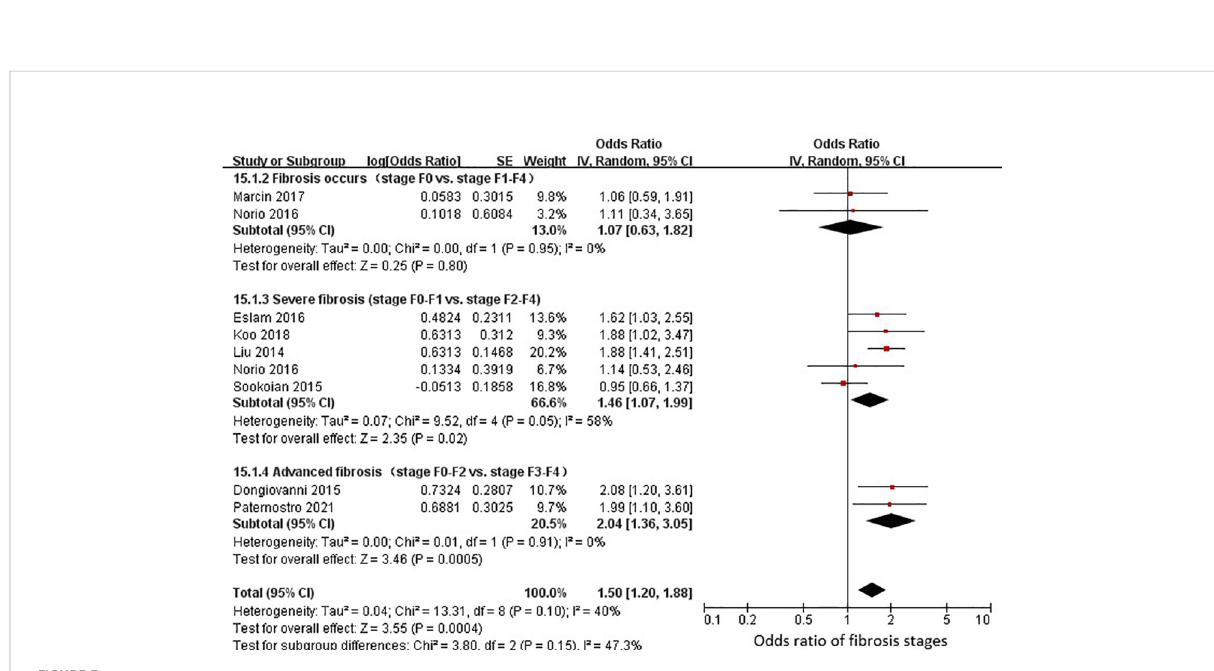
FIGURE 3 rs58542926 T allele was associated with a higher odds ratio with fi brosis stages. Data from 4928 individuals with liver biopsy. The rs58542926 T allele was positively associated with severe and advanced fi brosis stages (using a dominant model of inheritance). Meta-analysis was performed using random effects with the DerSimonian − Laird method for estimation of tau 2 ; CI, con fi dence interval; SE, standard